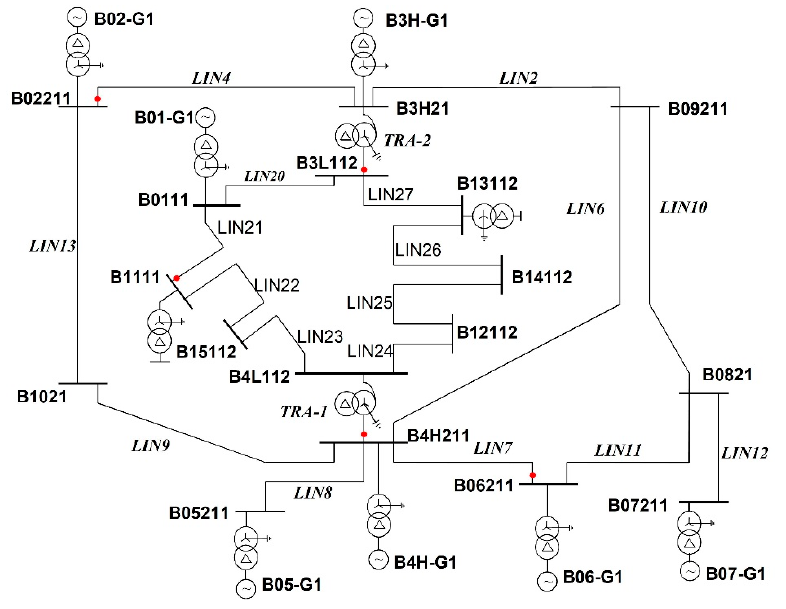
Figure 5. Modified CIGRE Test System.